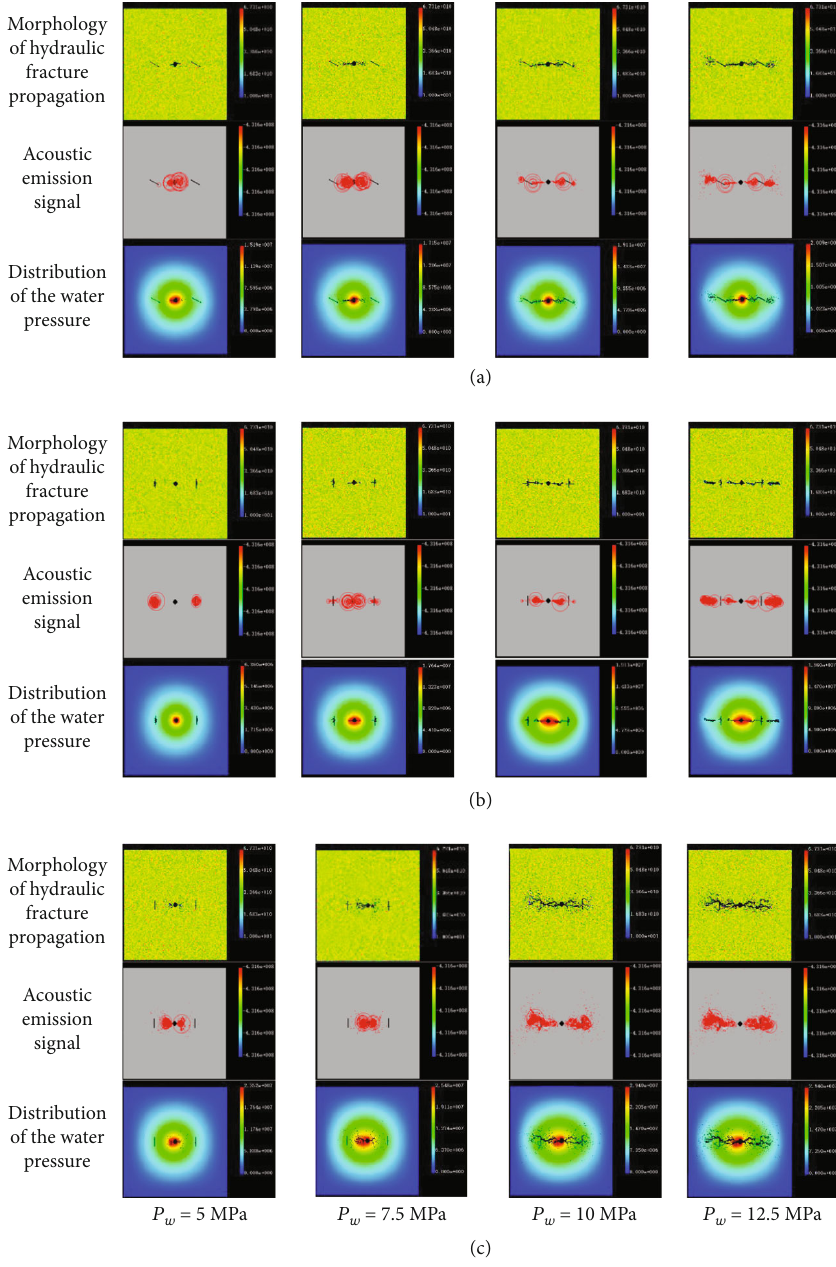
Figure 4: Propagation processes of a hydraulic fracture under the action of a natural fracture. (a) Propagation of a hydraulic fracture along a natural fracture. (b) Propagation of a hydraulic fracture penetrating the natural fracture. (c) Propagation of a hydraulic fracture through and along a natural